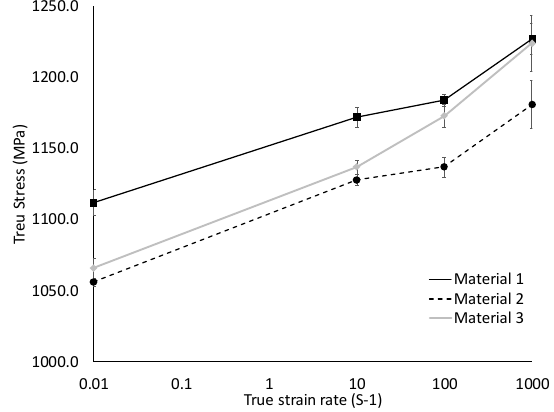
Fig. 12. Experimental strain sensitivity of each material studied. The average true stress at 6% true strain is presented. The length of the error bar is equal to the standard deviation from the